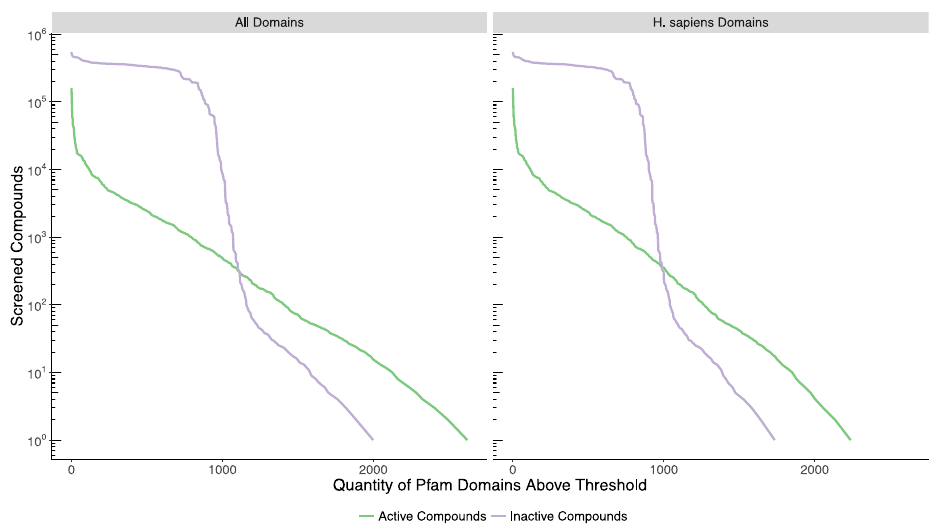
Fig 2. Pfam domain screening participation. The quantity of Pfam domainsis plotted on the horizontal (x) axis whose protein targets have at least as many active or inactive compoundsas shown on the vertical (y) axis. The left panel includesall Pfam domainsin the PubChemBioAssay targets, while the right panel includesjust those domainsalso present in the H. sapiens proteome, including non- H. sapiens targets which share a common domain with an H. sapiens